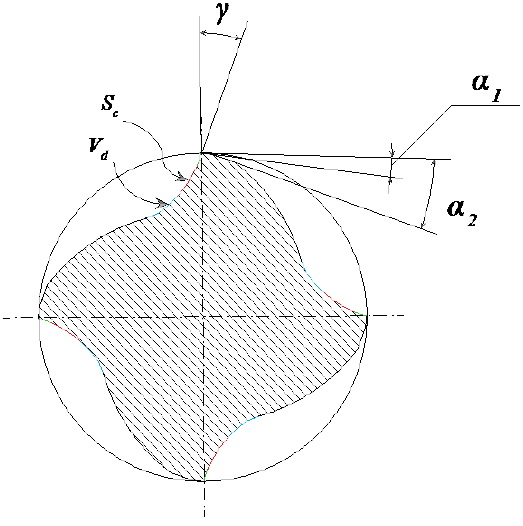
Fig. 1. Parameters of the chip groove